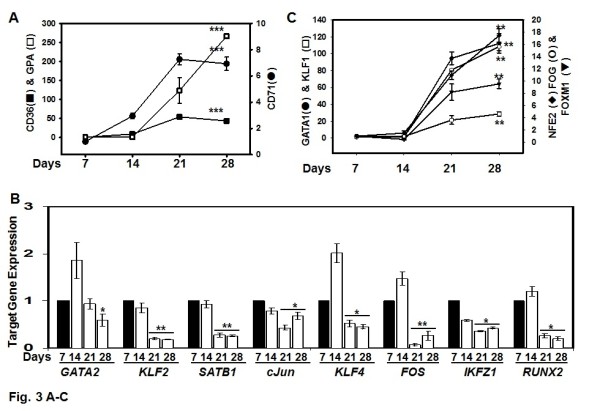
Gene expression analysis of transcription factors known to regulate globin gene expression. A) Gene expression patterns for established erythroid markers are shown. Note the different scales for the left and right Y-axis to reflect the magnitude of difference in gene expression. Shown is the mean ± SEM; *** = p < 0.001. B) Time-course curves of genes previously reported to be involved in γ-globin regulation are shown; * = p < 0.05; ** = p < 0.01. C) Graphed is the expression profiles for genes known to regulate β-globin expression. The raw data for the genes shown are included in Additional file 2: Table S1, Additional file 3: Table S2, Additional file 4: Table S3, Additional file 5: Table S4.